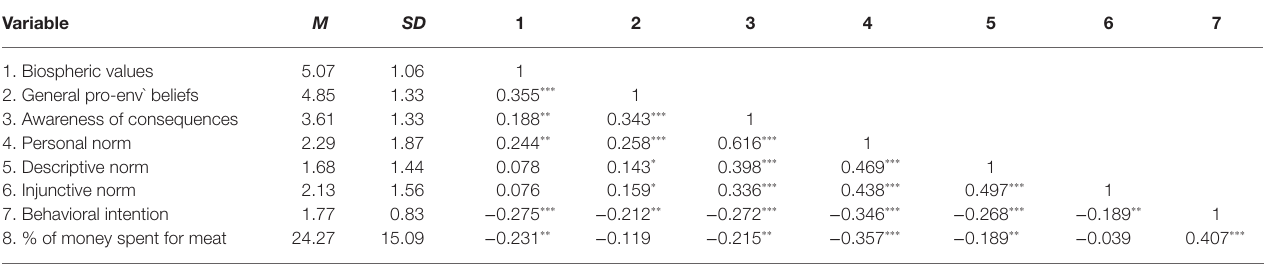
TABLE 1 | Descriptive statistics and correlation coefficients of Study 1. Variable